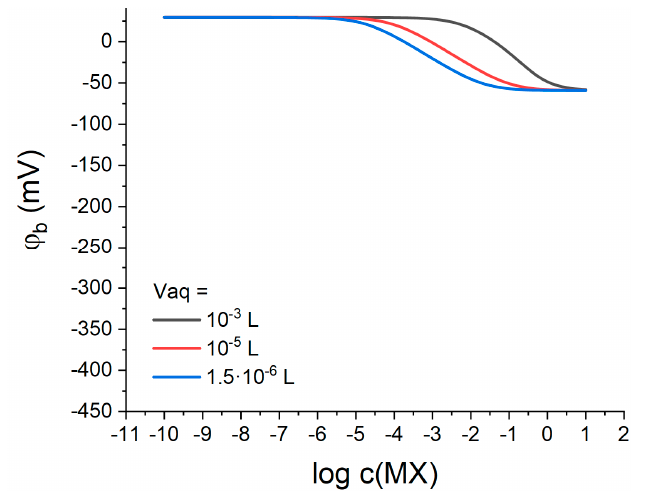
Figure 7. The simulated response of Q + B − -containing membranes to aqueous electrolyte concentra- tion for various volumes of the aqueous phase (indicated in the plot). Simulation parameters: c ( QB ) = 10 − 5 M, V m = 10 − 5 L; k M = 10 − 6 , k X = 10 − 4 ; k Q = 10 3 , k B = 10 2